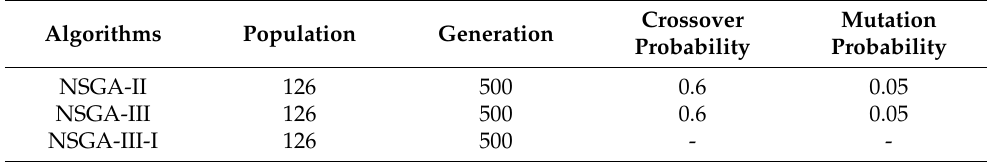
Table 4. Parameters of each